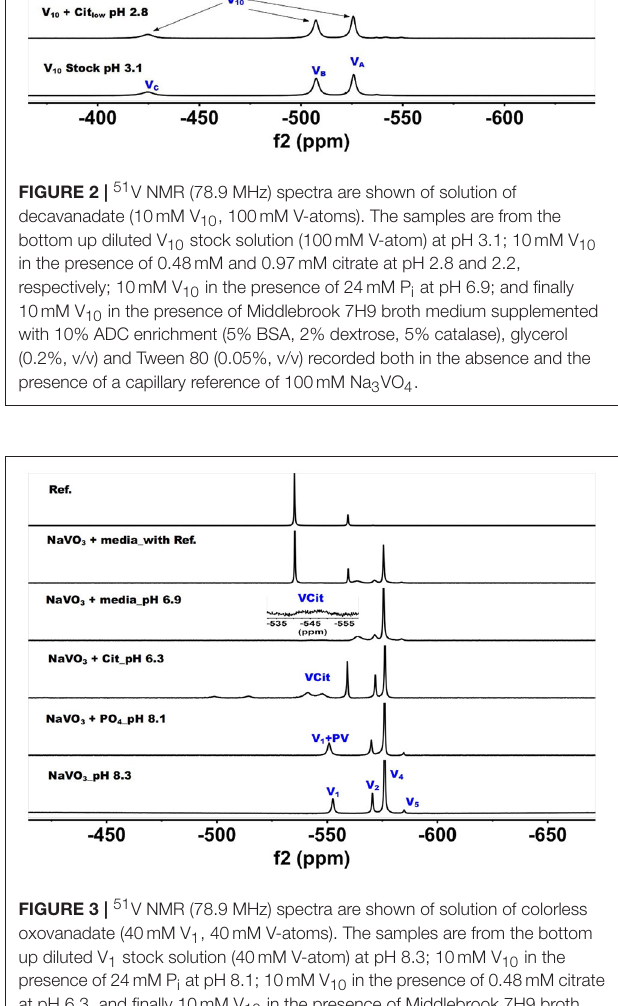
and assignment of the species that form in the growth media (see below Figure 4 ). Importantly, all the spectra are referenced against a reference sample (labeled Ref. in Figure 3 , containing 100 mM Na 3 VO 4